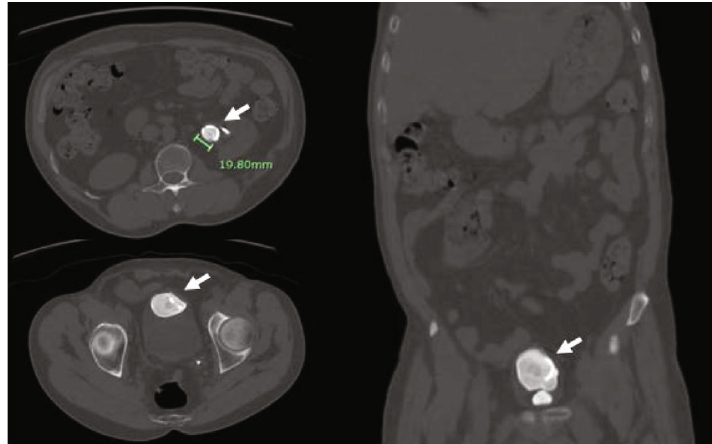
Figure 1: Patient 1 preoperative CT scan showing severe encrustation of the left ureteral stent at the proximal and distal coils